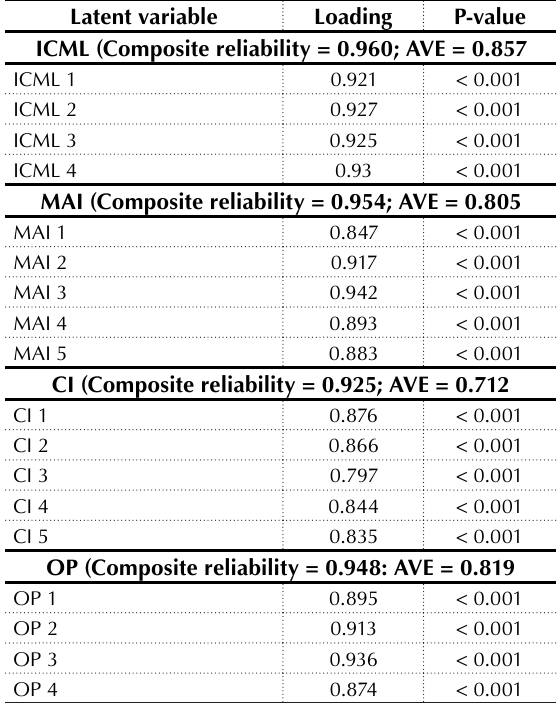
Table 3. Reliability and convergent validity